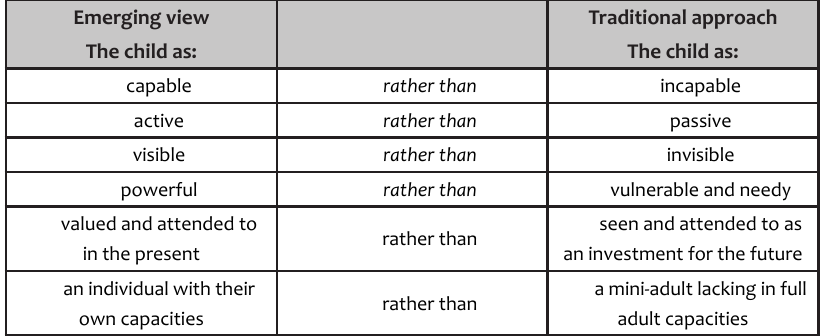
Table 1: Emerging and traditional attitudes to children Emerging